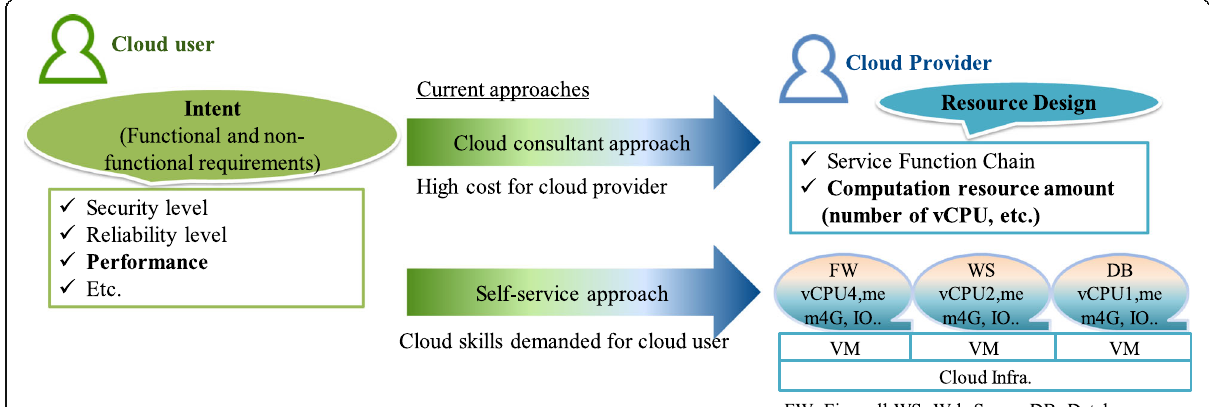
Fig. 1 Cloud user and cloud provider speaking different layers of “ language